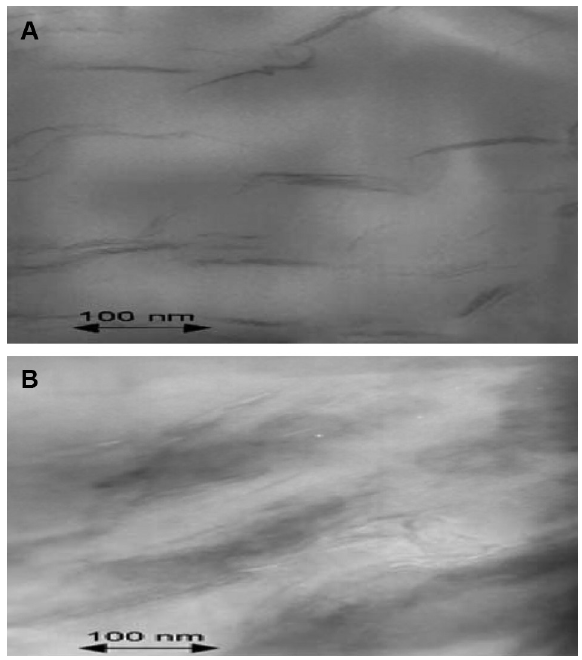
Figure 2 Transmission electron microscopy (TEM) micrographs of polypropylene/wood flour/organomodified montmorillonite (OMMT) nanocomposite: (A) 3 phc OMMT; (B) 6 phc